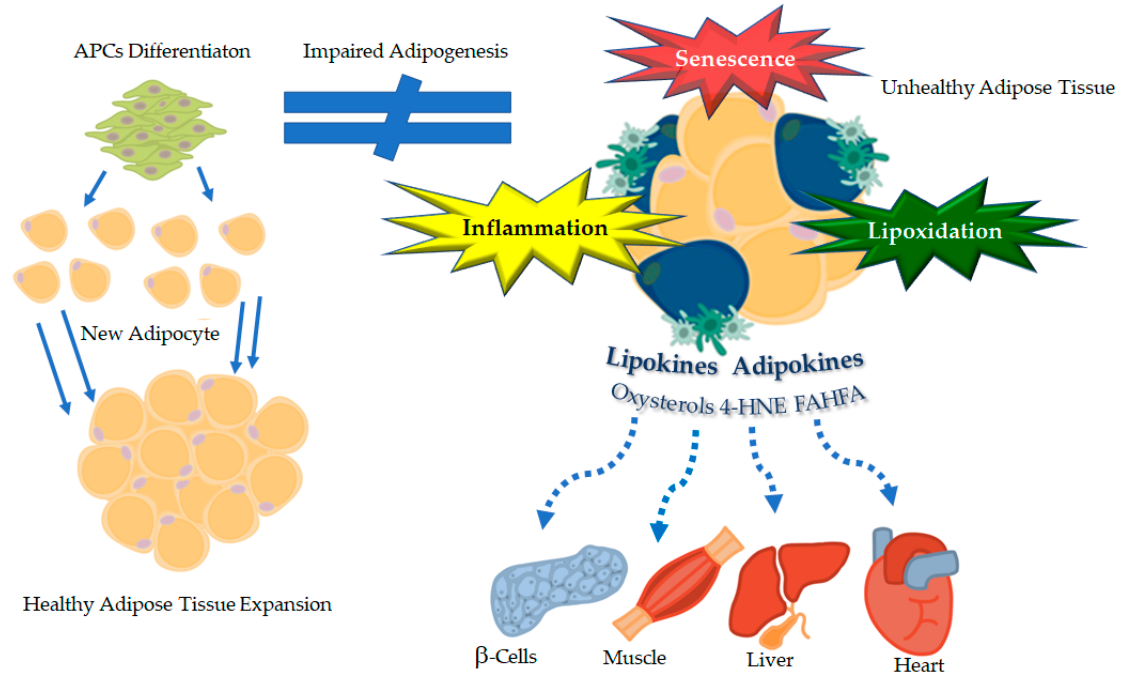
Figure 2. The novel “triad” of dysfunctional fat, inflammation, lipoxidation and senescence, as a key driver of obesity-linked cardiometabolic complications. APCs, adipose precursor cells; 4-HNE, 4-hydroxynonenal; FAHFA, fatty acid esters of hydroxy fatty acids.